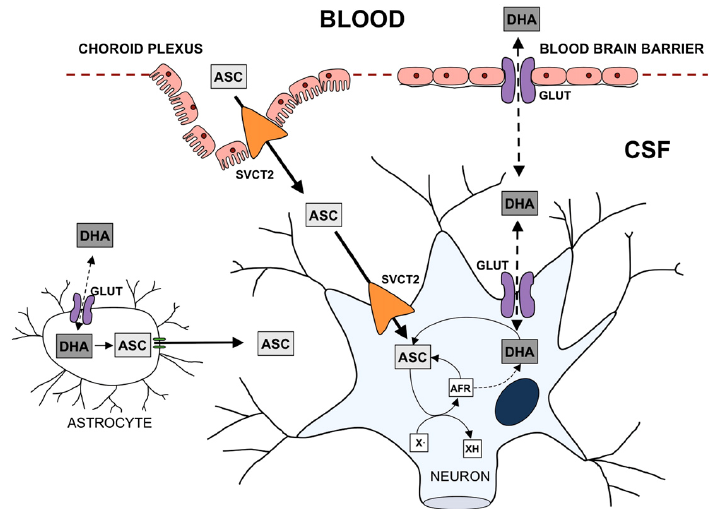
Figure 1. Transport of AA and DHA through the